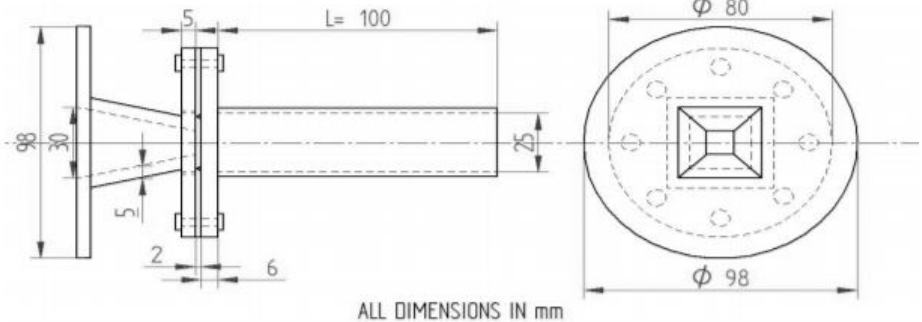
Figure 6. Dimensions of the nozzle and the duct [6].